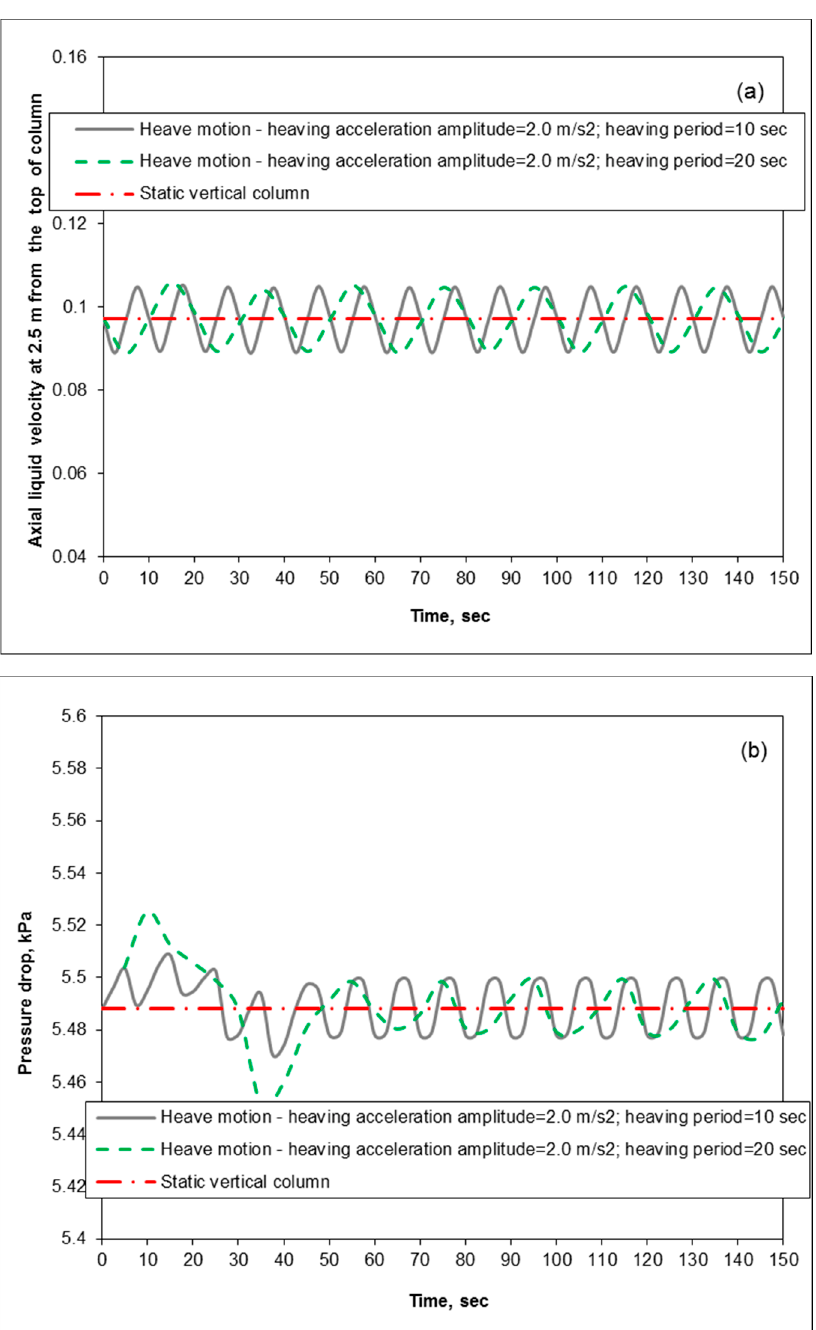
Figure 19. Time-dependent cross-sectionally averaged axial liquid velocity ( a ) and two-phase pressure drop ( b ) in a seawater scrubber under heaving motion conditions at different heaving motion periods (Packed-bed column with Raschig super-Rings; H = 5 m; Pressure = 1.5 MPa).